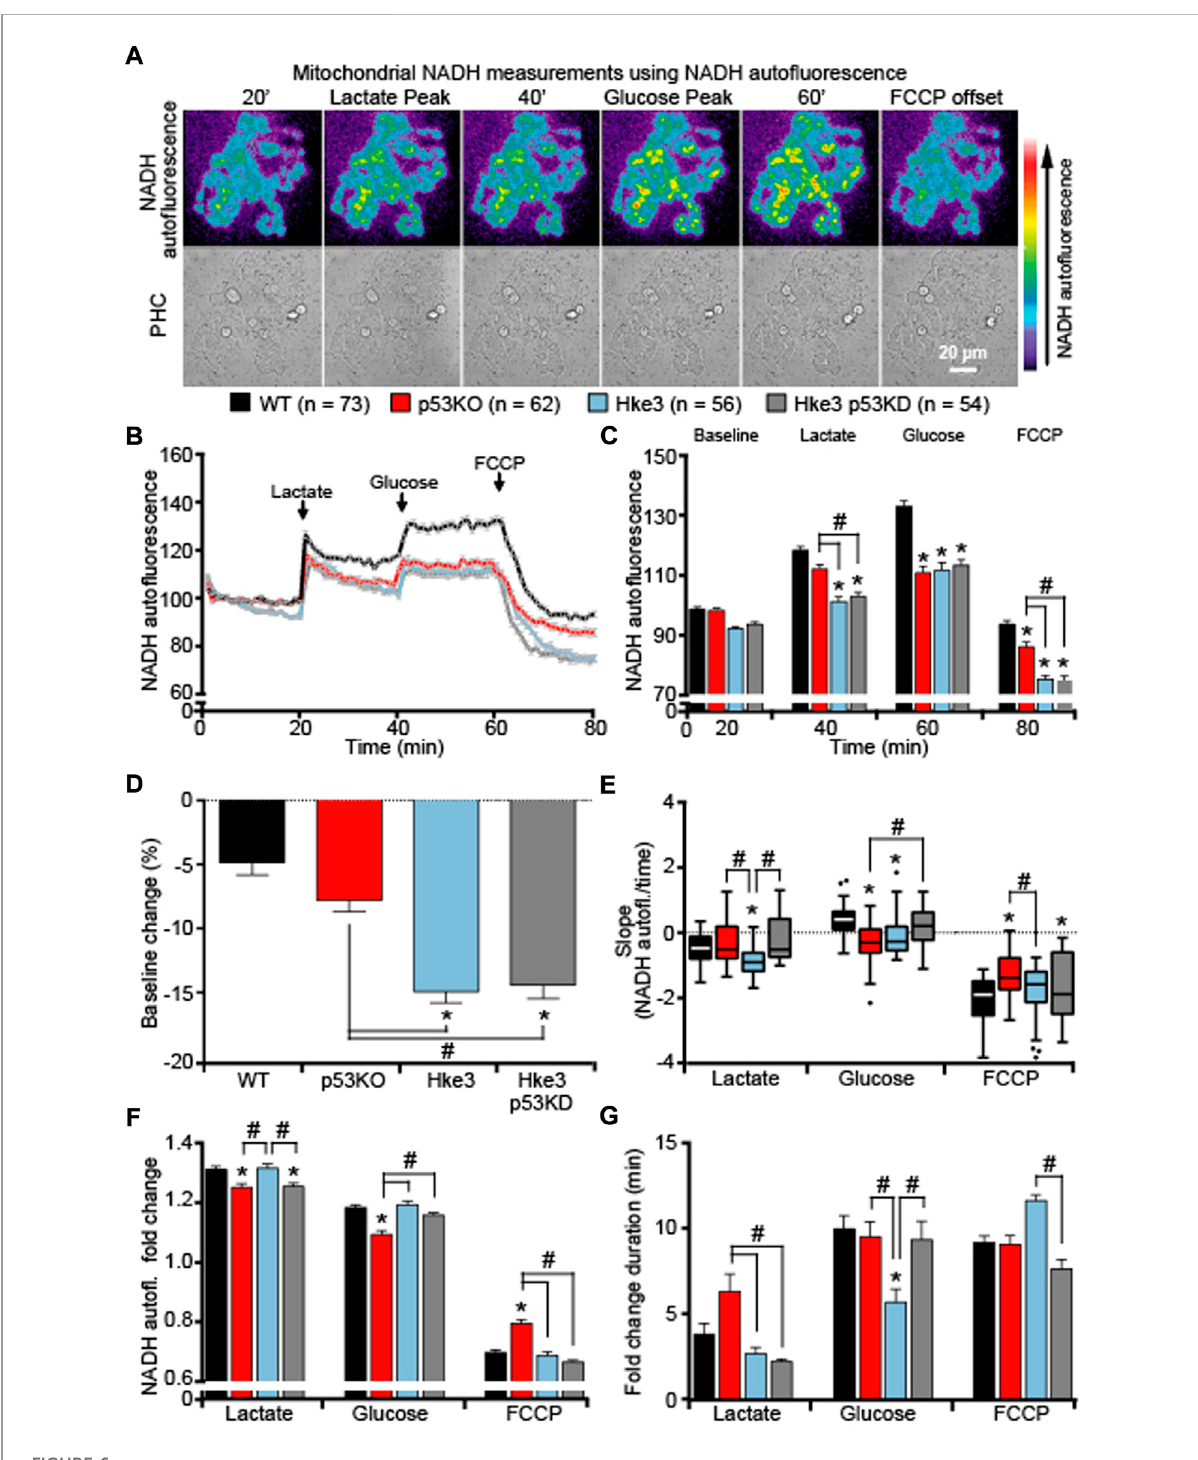
FIGURE 6 TP53 -de fi cient KRAS mutatedcellsdisplaymajoralterationsinmitochondrialNADHinresponsetometabolicsubstrates.WT,p53KO,Hke3and Hke3 p53 KD HCT-116 cells were separately mounted on the heated stage of an Axiovert 200 M motorized microscope and assayed over 80 min at 37 ° C. Cells were exposed as mentioned and illustrated in Figure 1A. Fluorescent measurements were recorded for NADH auto- fl uorescence and phase contrast (PHC) by time-lapse fl uorescence microscope. Fluorescent imaging data are expressed as NADH fl uorescence normalized to baseline. (A) Representative imaging data of Hke3 cells show the inhomogeneous fl uorescence of NADH per cell re fl ecting the predominant mitochondrial localization and are selected to illustrate levels before and after drugs addition. Scale bar = 20 µm. (B) Kinetics normalized to baseline